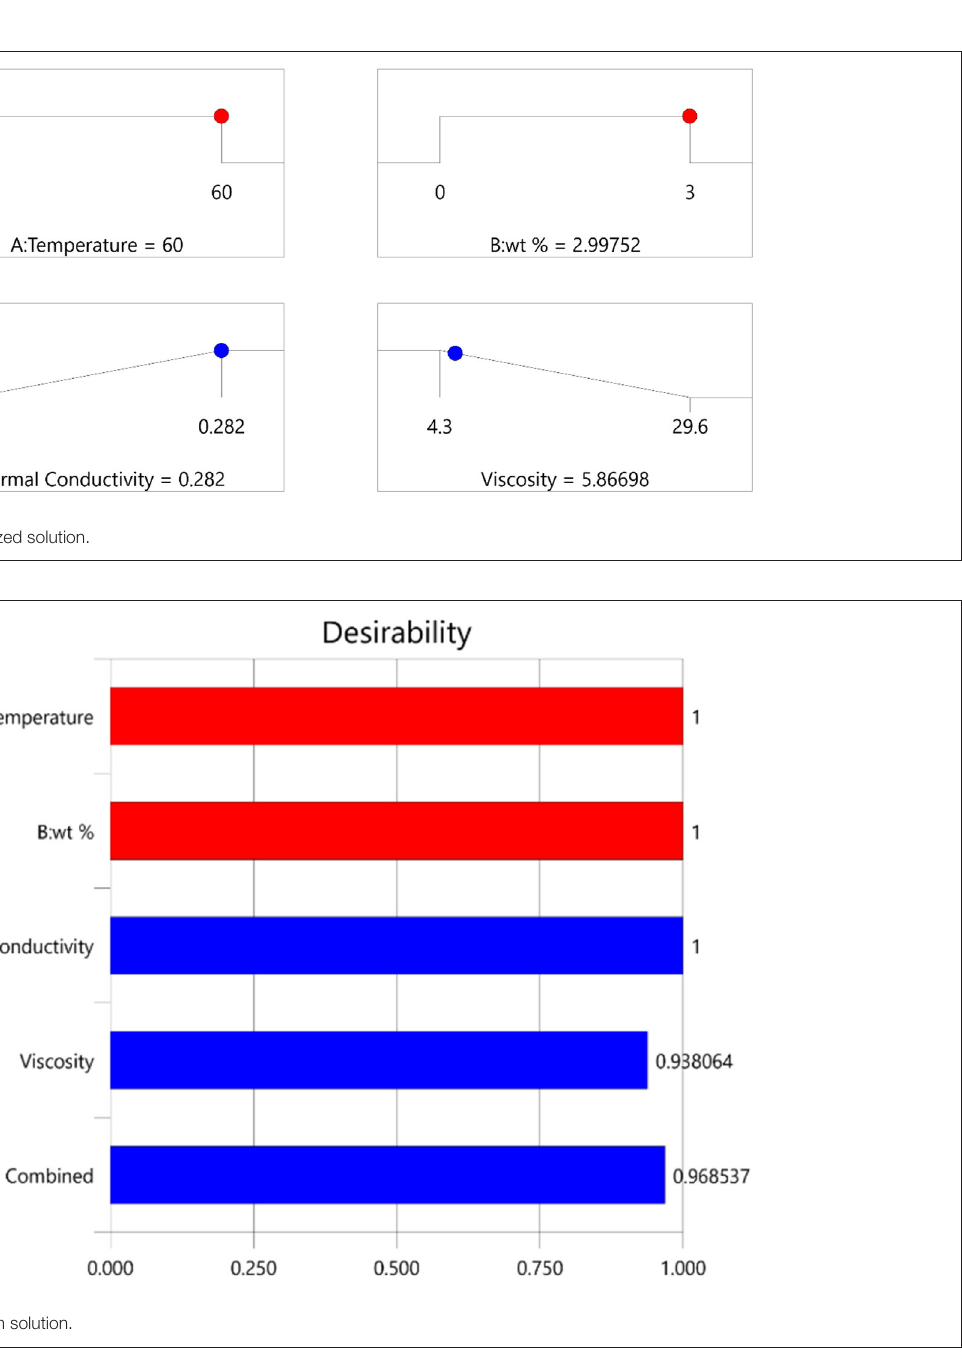
FIGURE 6 | Bar graph for the optimum